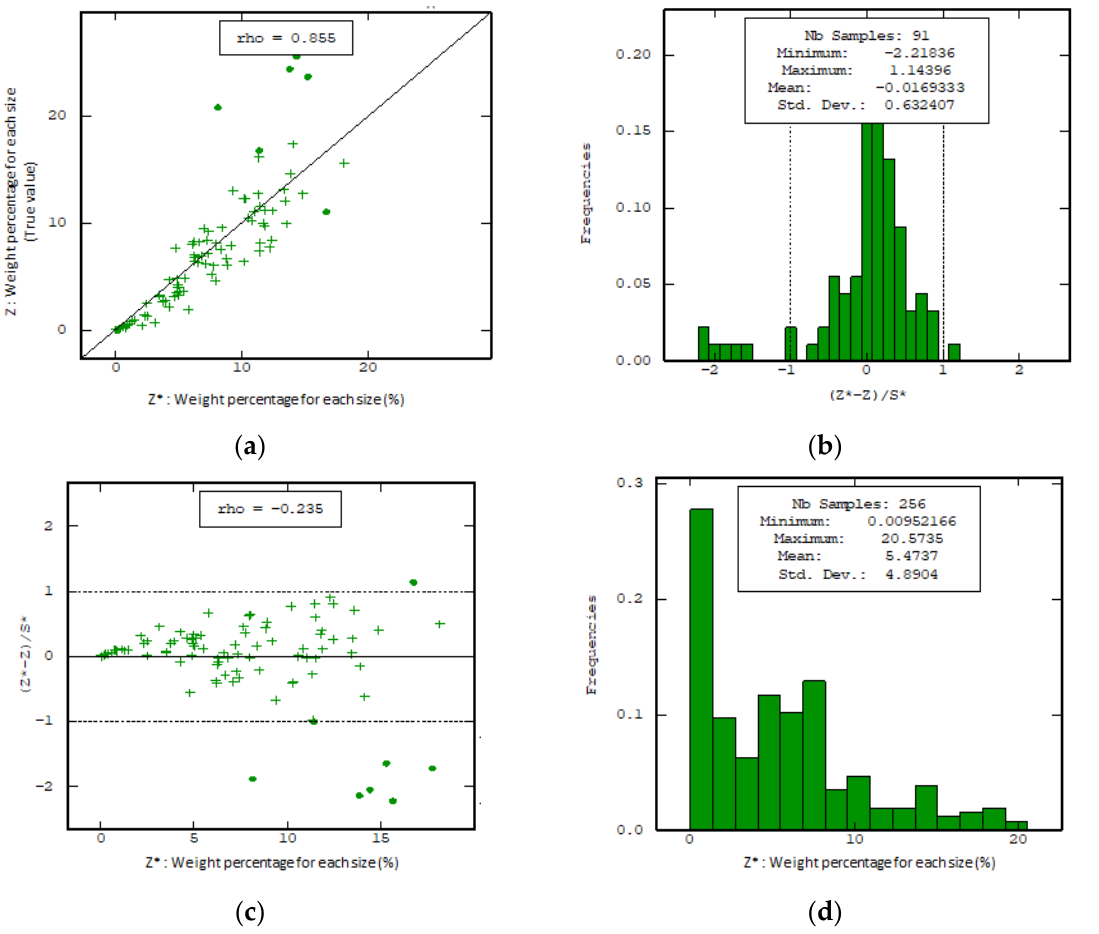
Figure 8. Cross-evaluation of the geostatistical analysis of LGP-1 with ore-B: (a) scatter plot (identity line) on the x-axis is the modeled data, and the y-axis shows the experimental data; (b) standardized error histogram; (c) standardized error based on the estimated value; and (d) histogram and its sta- tistical parameters of the estimated data.